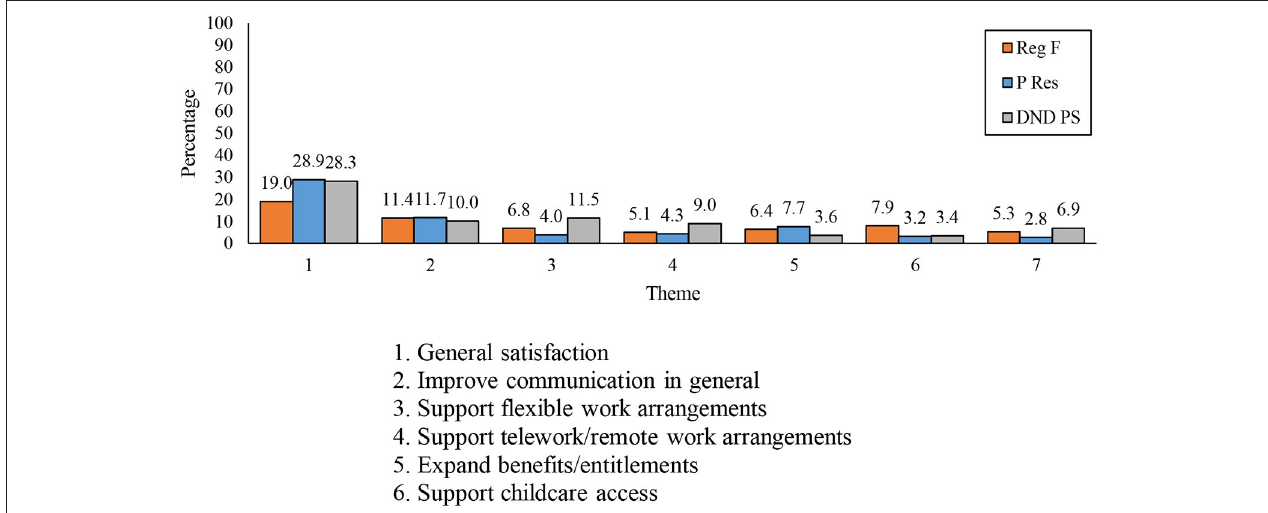
FIGURE 10 | Seven most frequently mentioned themes relating to how the DND/CAF can better support personal and family needs during the COVID-19 pandemic, by component.